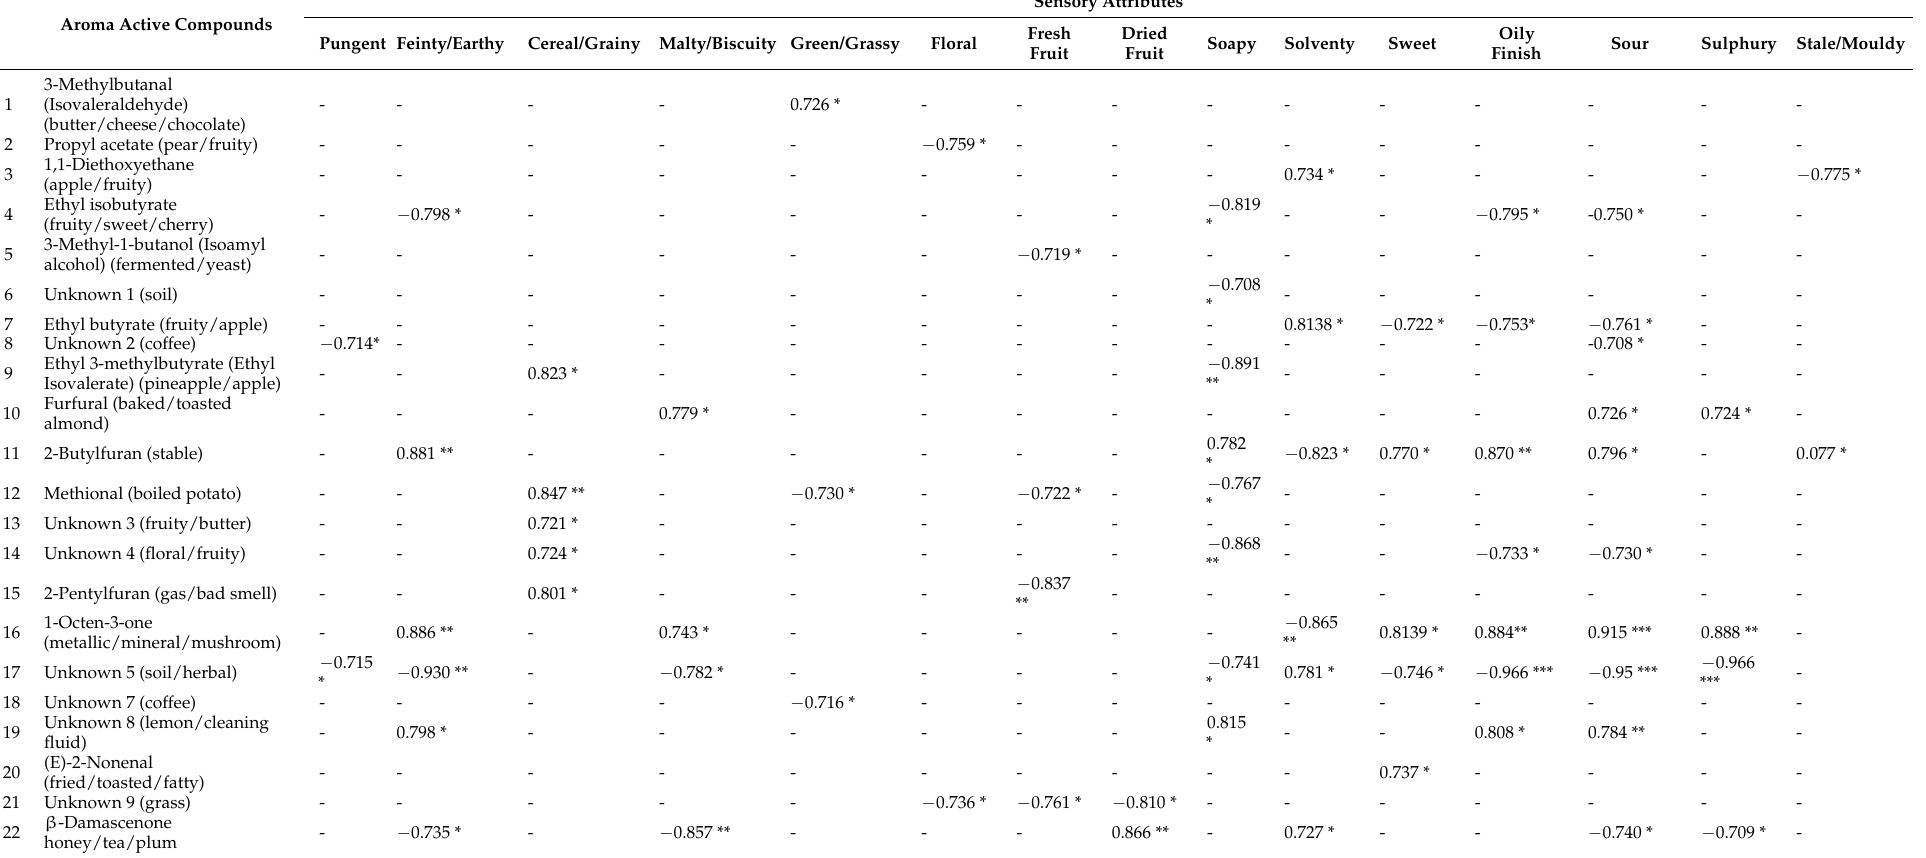
Table 4. Pearson’s correlation coefficients obtained between sensory attributes and MF% values of aroma active compounds. Aroma Active